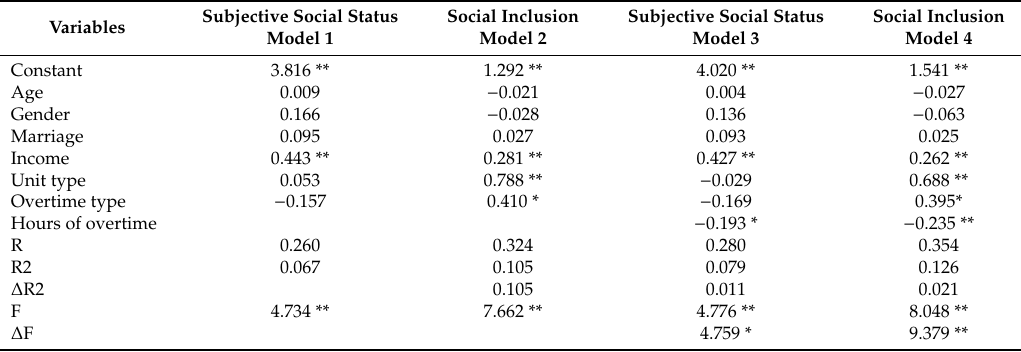
Table 3. Unstandardized regression coe ffi